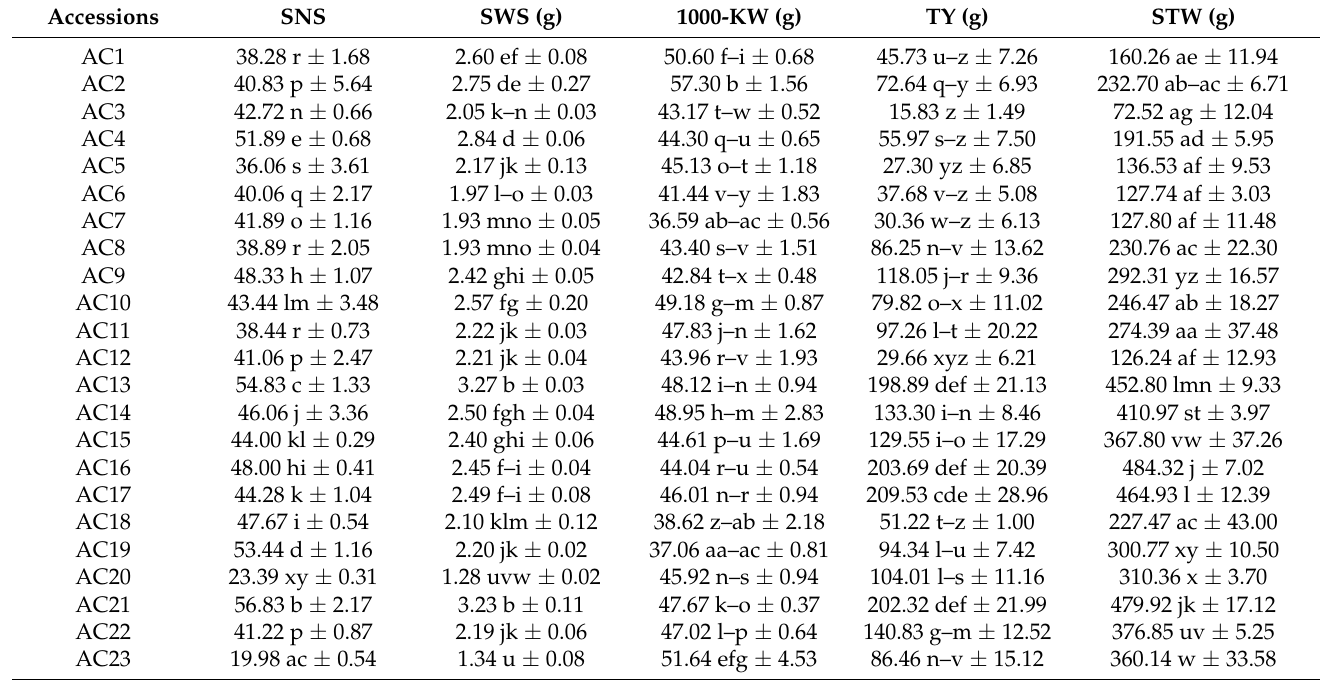
Table 6. Mean pairwise comparison between 59 barley accessions for number of seeds per spike, seed weight per spike, 1000-kernel weight, total yield per plot, and straw weight per plot traits after application of moringa plant extract based on Duncan’s multiple range test at p ≤